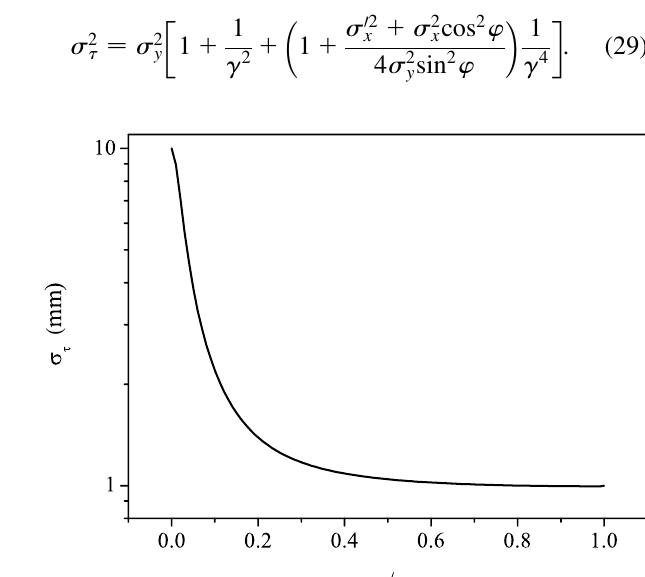
FIG. 4. Single electron x-ray pulse duration (1) and single